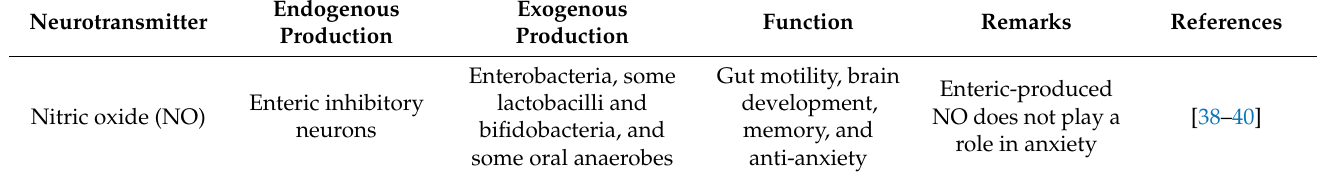
Table 1. Common neurotransmitters and short chain fatty acids, their production, and